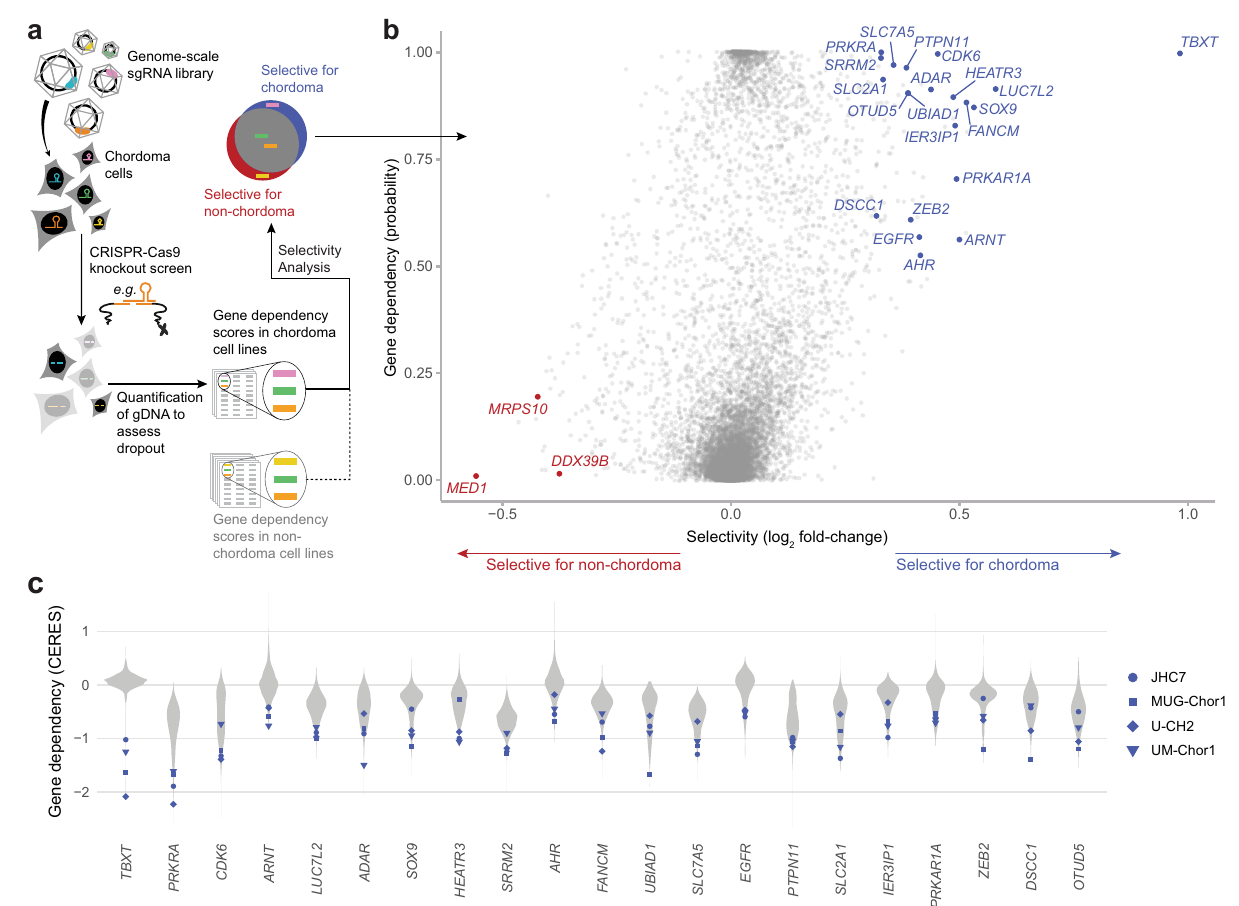
Fig. 1 | Genome-scale CRISPR-Cas9 screens identify a spectrum of selectively essential genes in chordoma. a Experimental work fl ow of genome-scale CRISPR- Cas9 loss-of-function screens to identify selectively essential genes in chordoma. b Selective essentiality analysis identifying chordoma dependency genes. Selec- tivity is quanti fi ed by the log 2 fold-change in mean dependency probability scores between four chordoma and 765 non-chordoma cell lines (x-axis). The y-axis depictsthemediandependencyprobabilityscoreforthechordomacelllines.Gene dependenciesselectiveforchordoma/non-chordomaareindicatedinblue/red(see